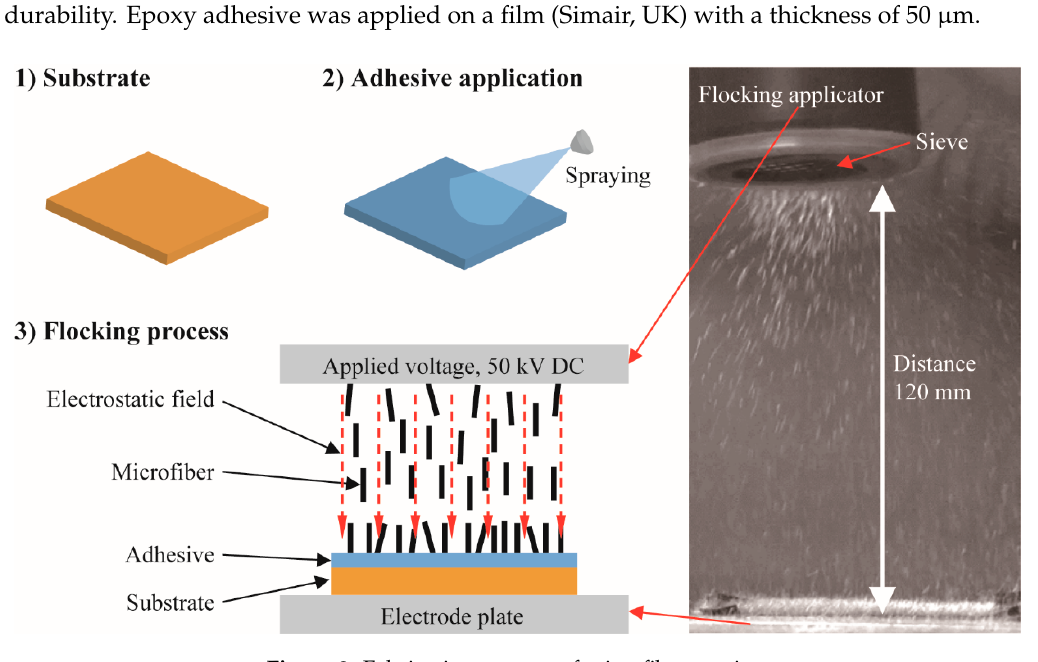
Figure 2. Fabrication process of microfiber coating.